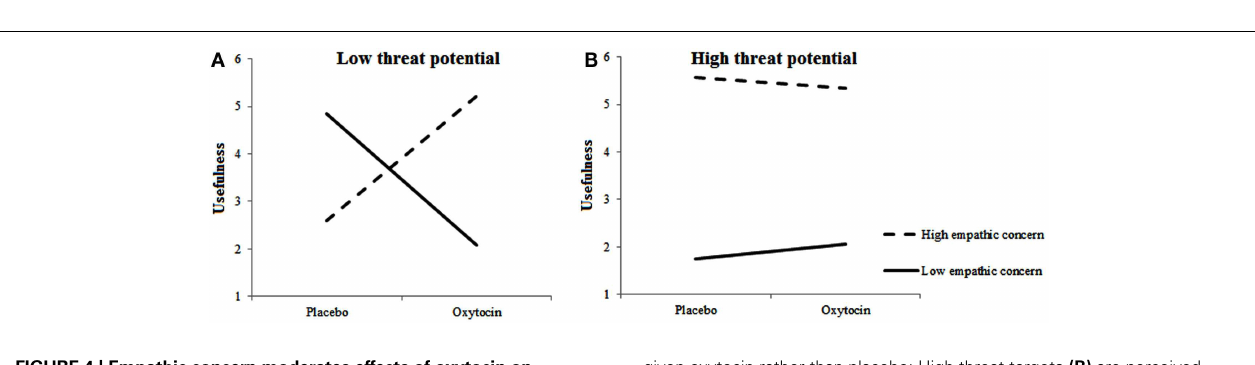
FIGURE 4 | Empathic concern moderates effects of oxytocin on usefulness of included targets. Low-threat targets (A) are perceived as less useful by individuals with high fetal testosterone exposure when